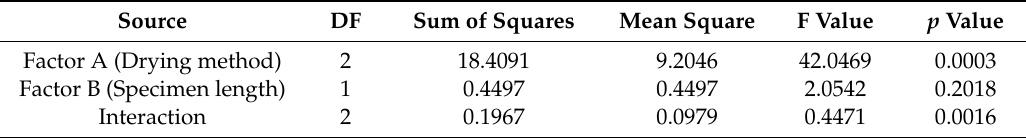
Table 4. Two-way analysis of variance with shrinkage